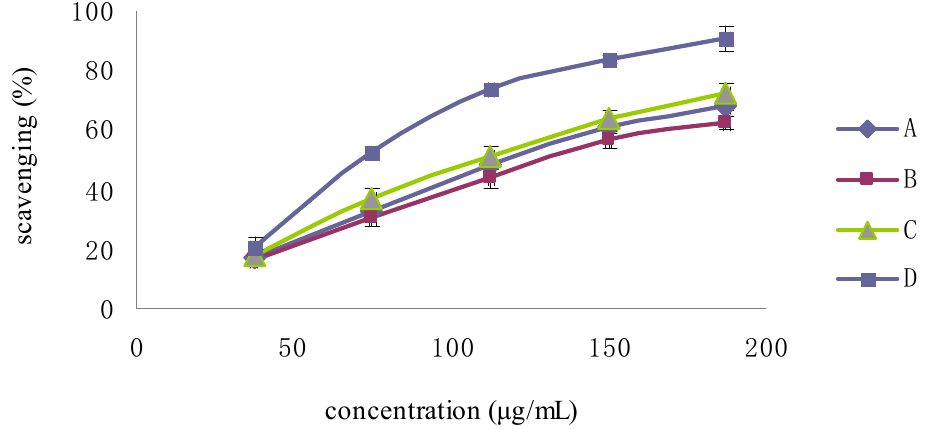
Figure 6. DPPH radical-scavenging activities of Fuco stereoisomers and VE as a function of their EC . ( A ) (all- E )-Fuco; ( B ) 9'Z-Fuco; ( C ) 13 Z - and 13' Z -Fuco; ( D ) VE. The EC 50s were calculated from the % scavenging ability of each compound (Figure